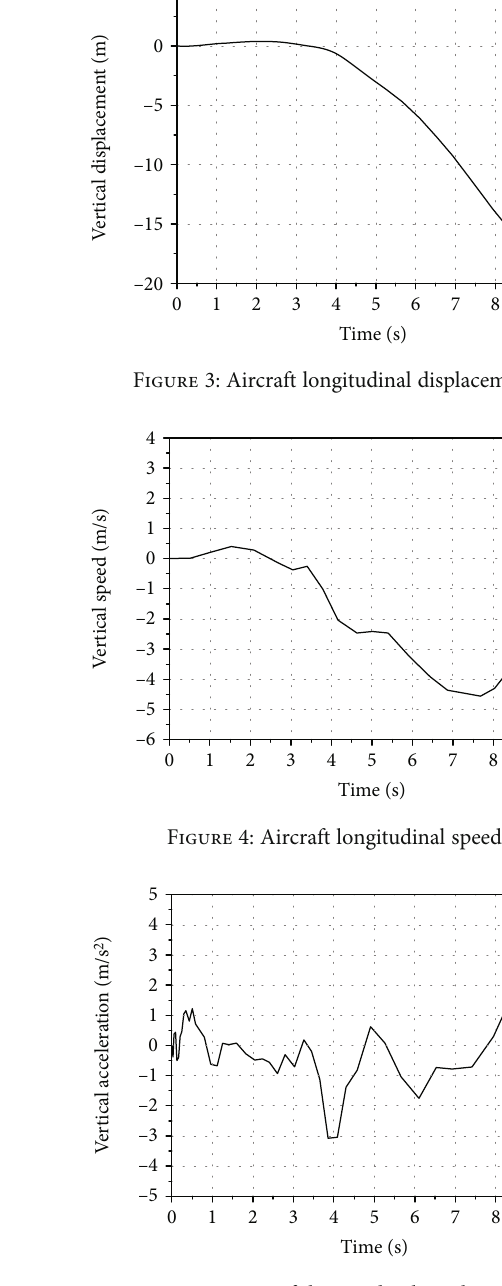
Table 1: Calculation parameters.